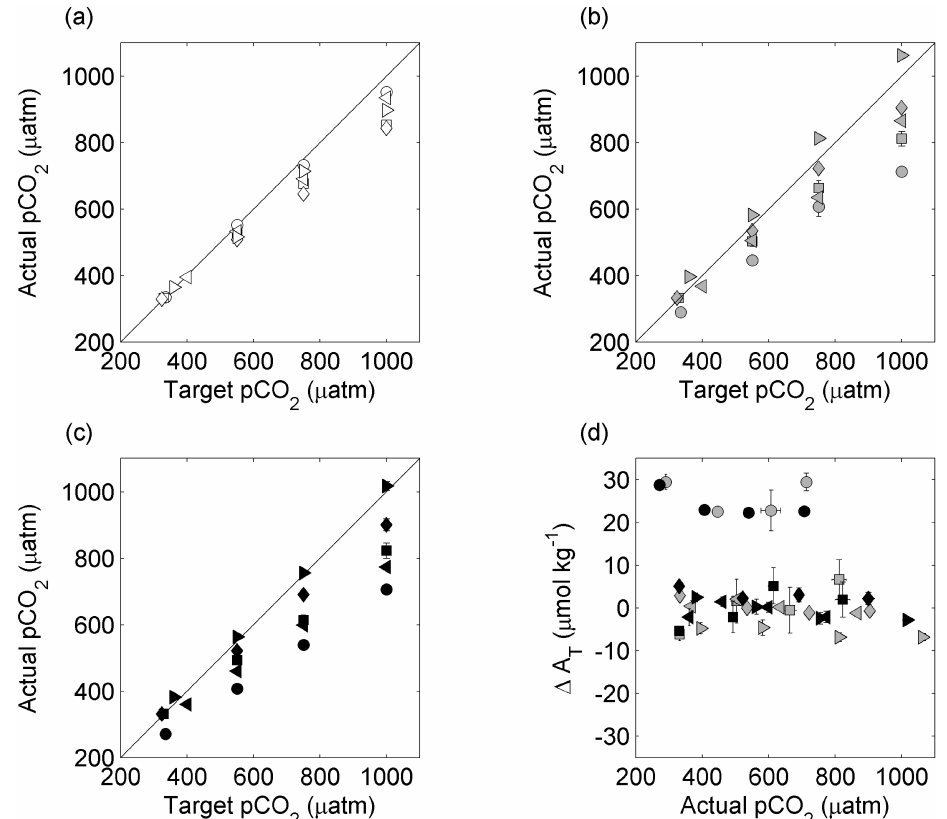
Figure 3. Carbonate chemistry evolution in the main bioassays through the incubation period. Plots illustrate targeted versus measured p CO 2 (µatm) at (a) T 0 , (b) 48h and (c) 96h and difference in A T between initial and subsequent time points ( 1A T ) (d) in all the five main bioassay experiments. Open symbols (a) indicate initial conditions, with grey ( b and d ) and black ( c and d ) symbols indicating 48h and 96h time points respectively. Symbol shapes indicate experiment E1 (circles), E2 (squares), E3 (diamonds), E4 (left pointing triangles) and E5 (right pointing triangles). Black lines in (a) , (b) and (c) indicate the 1 : 1 line. Plotted values are means ± 1 SE of biological